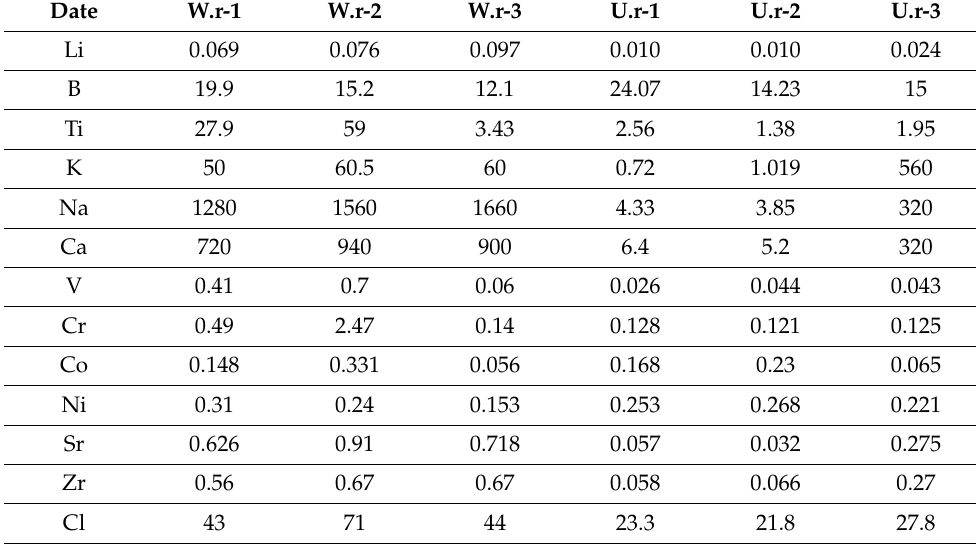
Table 4. The trace elements of the weathering rind and the unweathered serpentine jade (ppm).